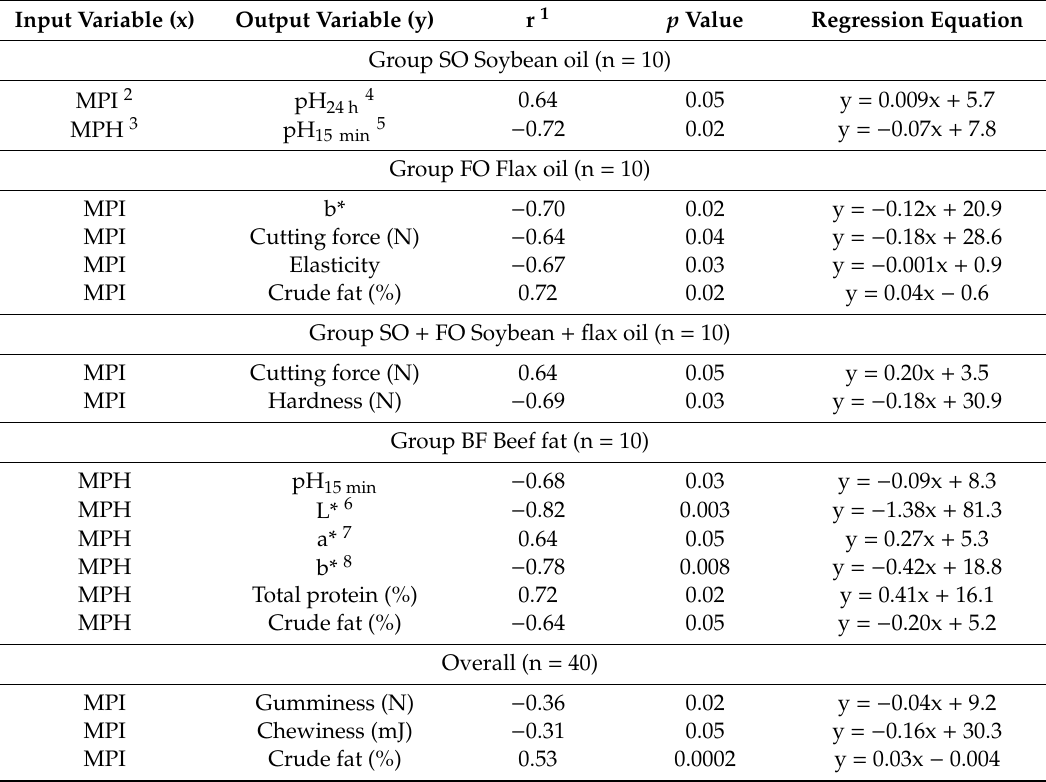
Table 3. Summary of significant correlations between echotextural variables and physical properties or the chemical composition of the pectoralis major muscles for each group of broiler chickens receiving four di ff erent types of dietary